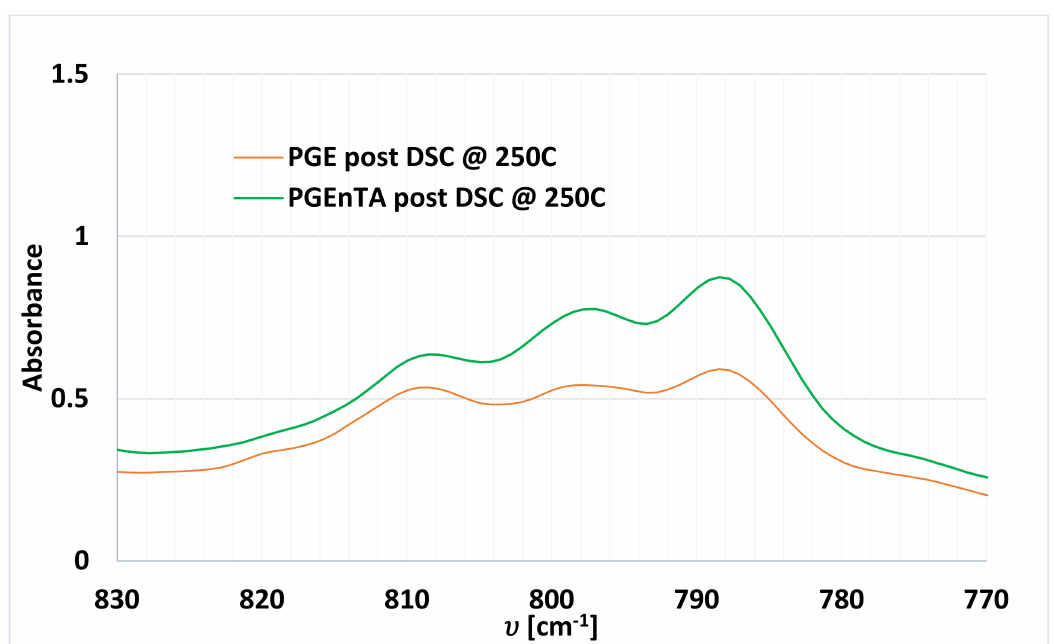
Figure 4. Pre-cured FTIR spectrum ( top ) and thermally post cured spectrum ( bottom ) of neat PGE and PGEnTA formulations.